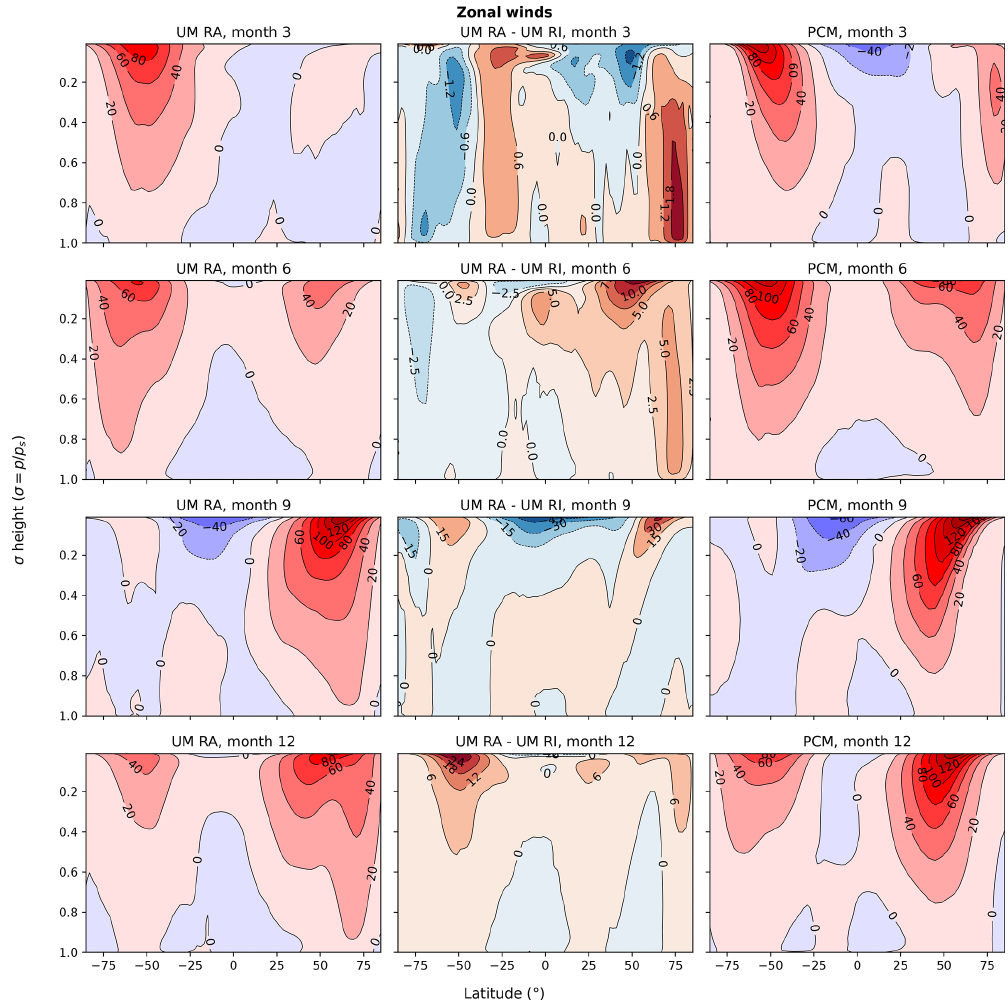
Figure 7. Zonal mean zonal winds (ms − 1 ) across four seasons within the Martian year. For each month, the time average is taken of all sols within that month. The RA dust scenario is shown on the left, the differences between the RA and RI dust scenarios are in the centre and the PCM output is on the right. Colour scales in the left-hand and right-hand plots are matched across all months and between models, with contour intervals of 20ms − 1 . The contours in the difference plots are not matched due to the varying intensity of the difference between months. Positive values indicate an eastward wind and negative values a westward wind. Appendix Figs. A1 and A6 show the same data but solely for the RA vs. RI and PCM outputs,